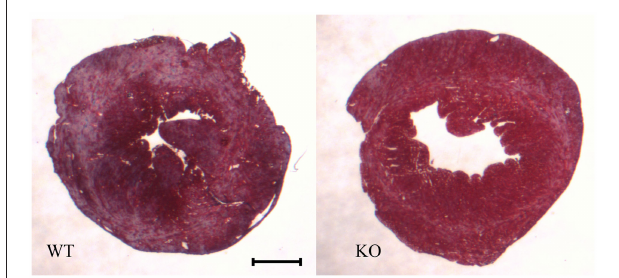
Table 1 . The average cross sectional area of WT cardiomyocyte fibers from the left ventricle is 325 µ m 2 ( SE ± 2 µ m 2 ), while